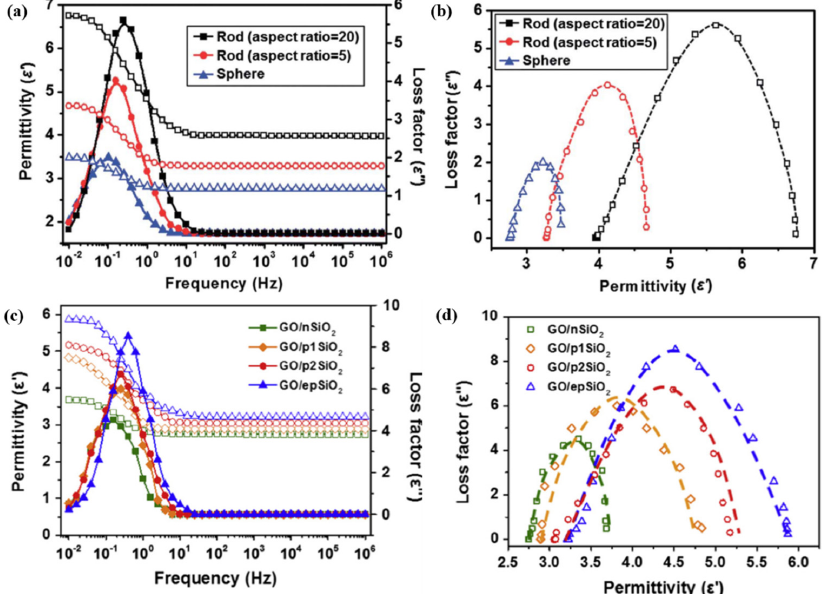
Figure 9. Dielectric properties of ER fluids based on ( a, b ) GO-wrapped silica with different aspect ratios [59] and ( c, d ) GO/SiO 2 spheres with different densities [59]